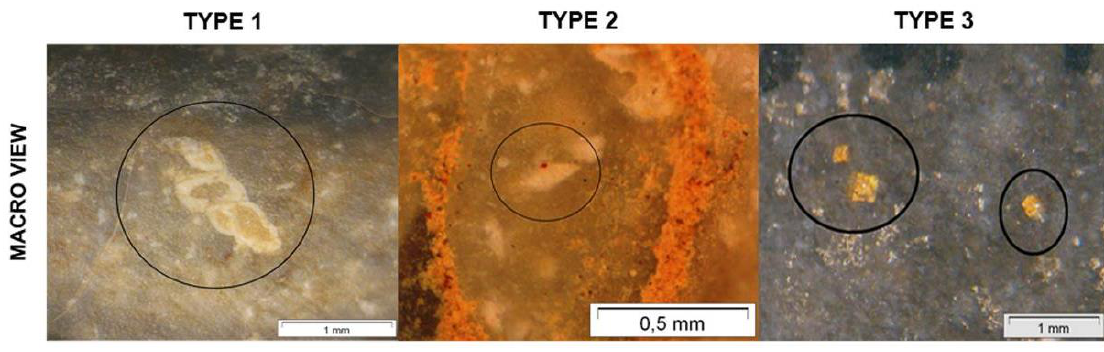
Figure 6. Main characteristics of each group (view from binocular microscope). Type 1: Gastropod section; Type 2: Lenticular gypsum pseudomorph; Type 3: Dolomite